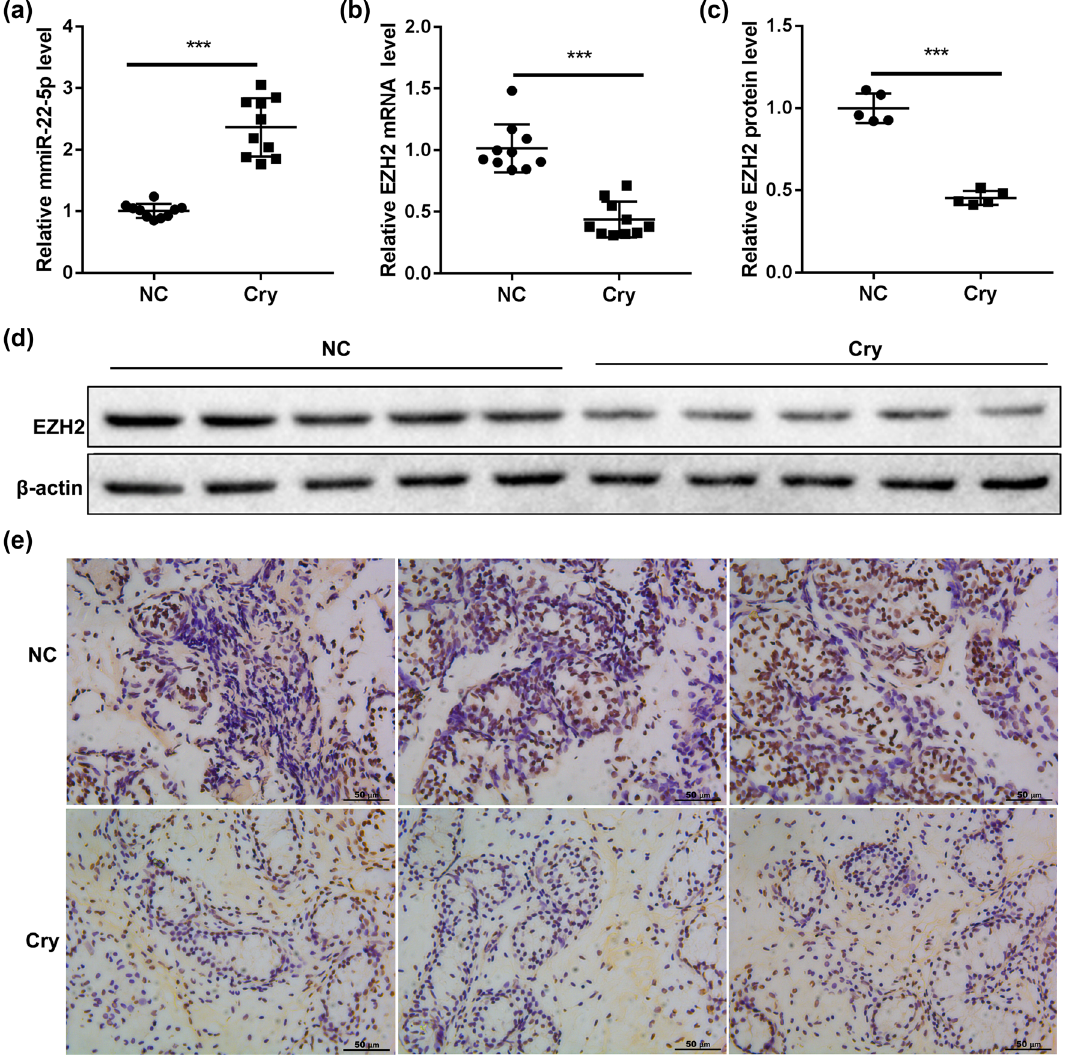
Figure 1: miR - 22 - 5p was signi fi cantly upregulated in the testicular tissues of patients with cryptorchidism. Testicular tissues of cryp - torchidism patients ( cry group ) and normal testicular tissues of fertile participants ( NC group ) were collected. ( a ) The expression of miR - 22 - 5p was detected by QRT - PCR. ( b – e ) The expression of EZH2 in the testicular tissues was detected by QRT - PCR, western blot, and immu - nohistochemistry ( scale bar = 50 µm ) . *** p < 0.001 vs NC